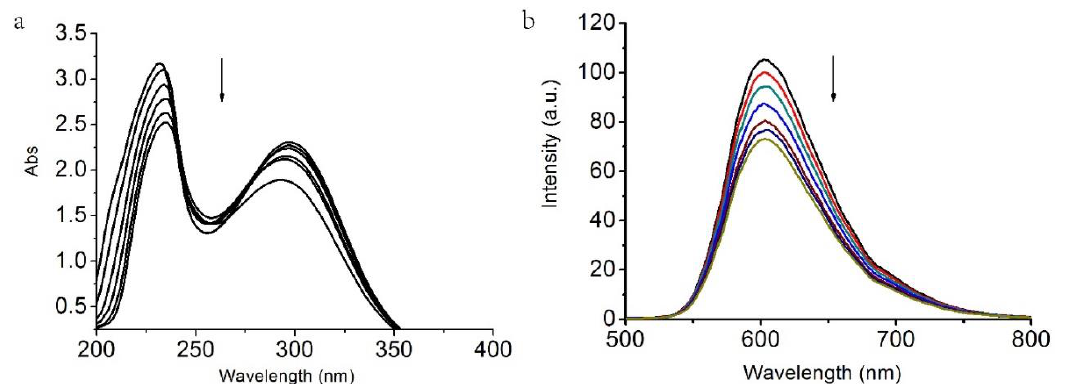
Figure 7. ( a ) Absorbtion spectra of complex 1 with increasing Calf-thymus DNA (CT-DNA). The arrow shows the absorbance changes with increasing DNA concentration. The concentration of the compound was 2.0 × 10 −5 M, r = [CT-DNA]/[compound] = 0–0.6. ( b ) Fluorescence emission spectra (excited at 305 nm) of the CT-DNA–EB (ethidium bromide) system (2.5 μM EB, 100 μM CT-DNA) in the absence and presence of 1 × 10 –4 M complex 1 with increasing concentrations of complex with 0 to 4 μM (from top to bottom).